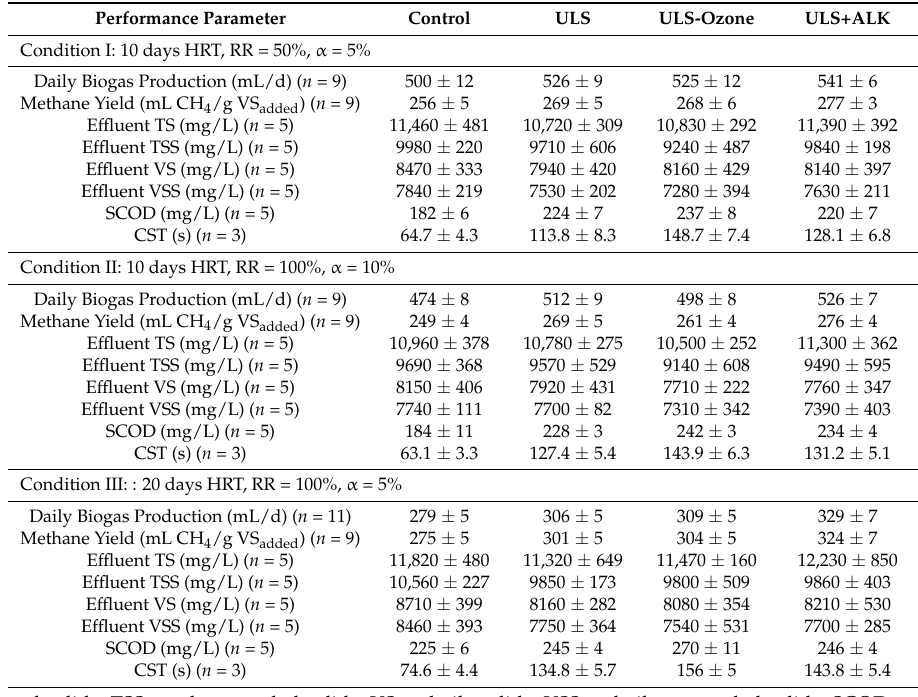
Table 3. Summary of anaerobic reactors performance when a post treatment was applied to digested sludge. ULS: ultrasound post-treatment; ULS-Ozone: ultrasound and ozone post-treatment; ULS+ALK: ultrasound and alkali